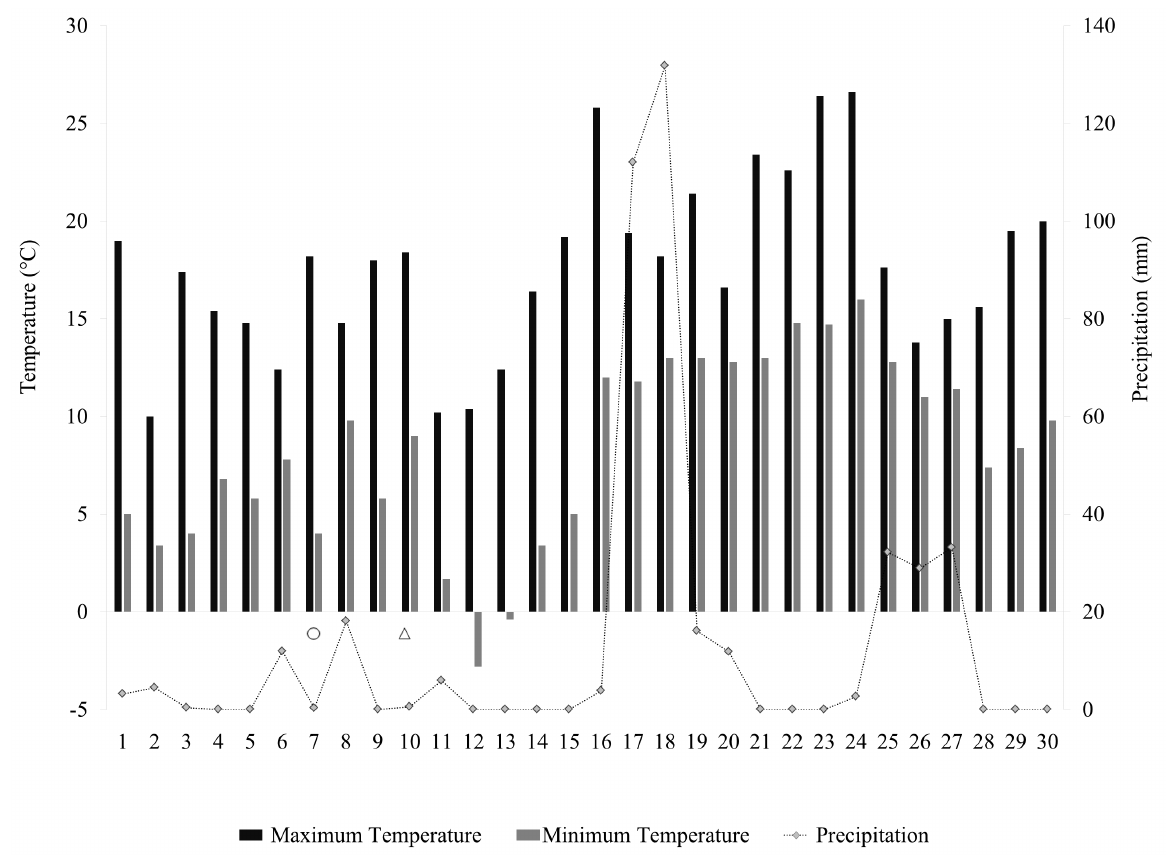
Figure 1 - Climatic conditions before and following the application of treatments in September 2015. Circle and triangle in the “x” axis denotes the time of TDZ application in ‘Hosui’ and ‘Packham’s Triumph’, respectively. São Joaquim, SC. Source: INMET/